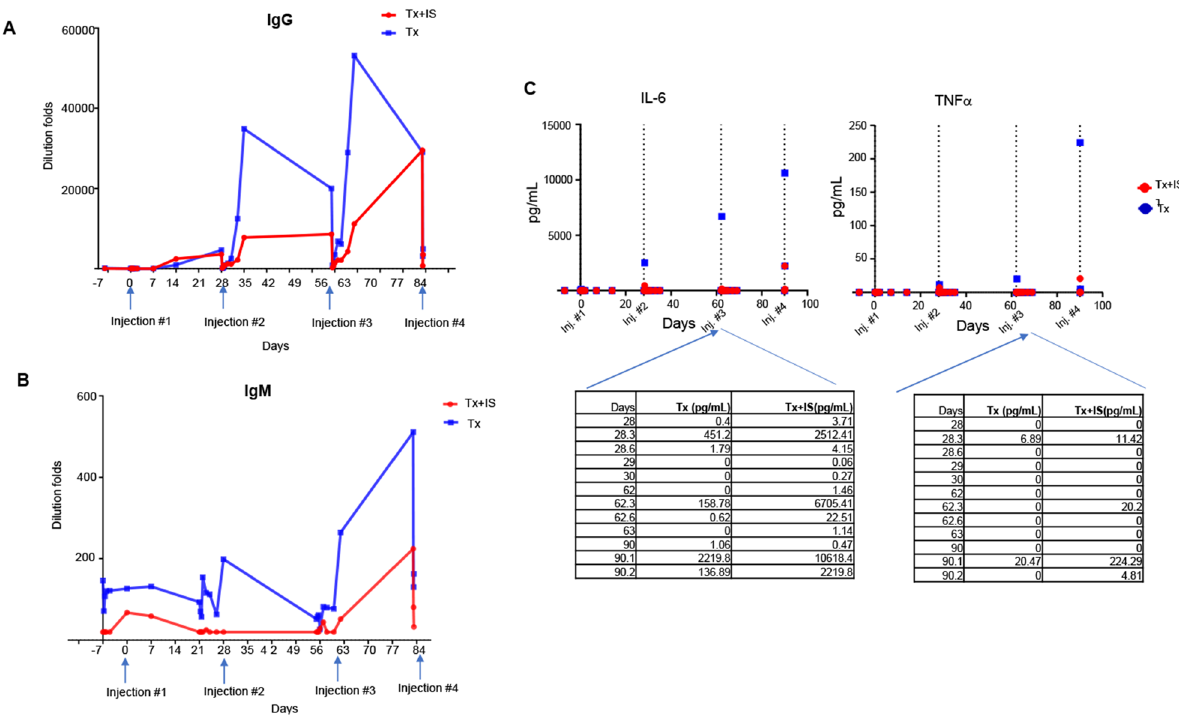
Figure 5. Non-GLP four-cycle toxicity/immunogenicity study with c-JO4 + Doxil in cynomolgus monkeys. ( A , B ) Serum anti-c-JO4 antibody titers . Anti-c-JO4 IgG and IgM titers were measured in at indicated time points by ELISA. ( C ) Serum cytokines. Serum samples were run on a Th1/Th2 inflammatory cytokine array using the CBA flow panel (BD Biosciences). The only cytokines above limit of detection were IL-6 and TNFα. Other cytokines tested included IL-2, IL-4, IL-10 and IFNγ. Inlet shows the values at and around each injection time